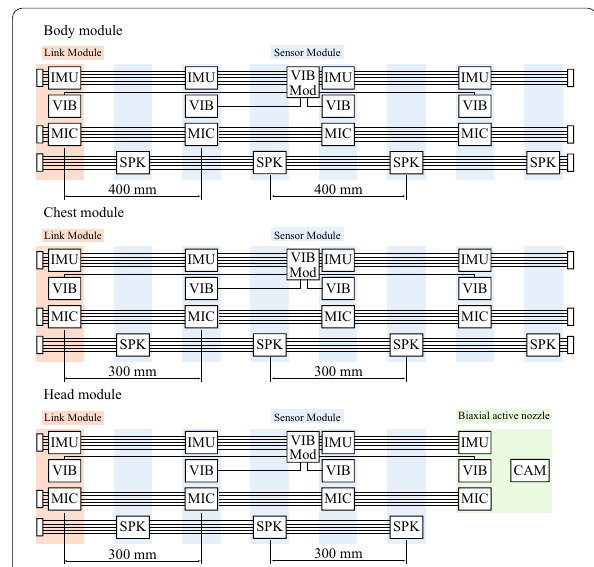
Fig. 6 Overview of the three types of modules with the different functions that were developed. From the top, they are the: body module, chest module, the head module. The body module is 1.6